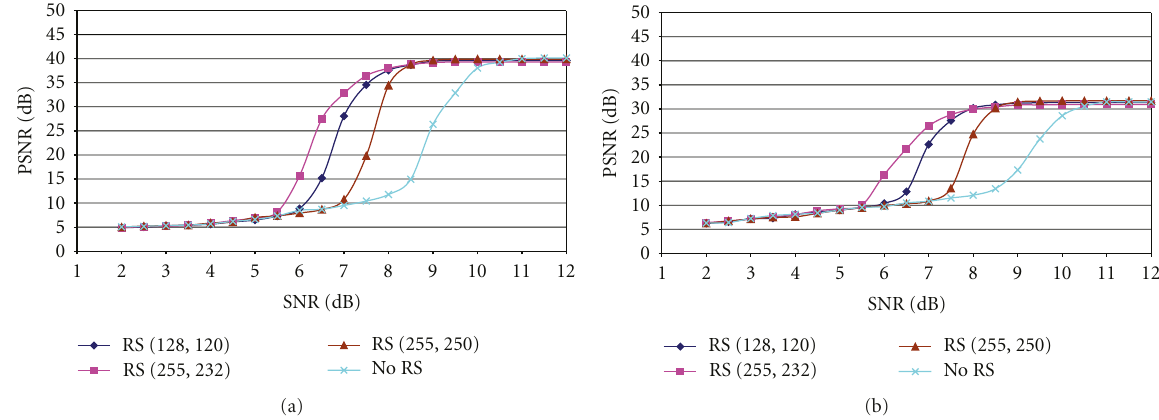
Figure 12: PSNR evolution for “HallMonitor” and “Mobile Calendar” sequences in QCIF resolution over BSC channel for di ff erent protection levels with RS codes.